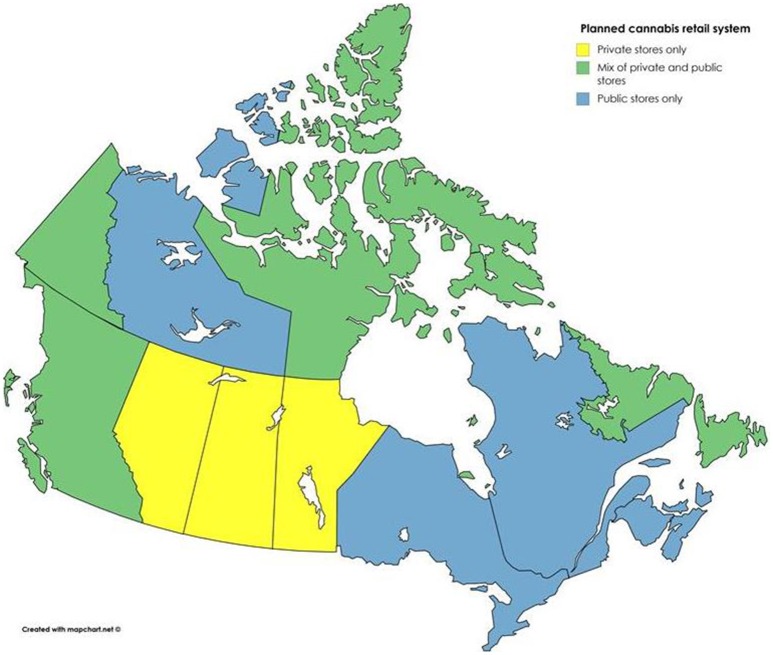
Retail data from (22).